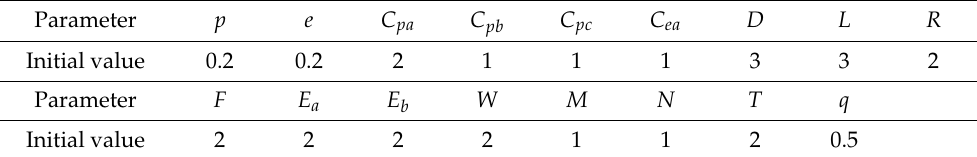
Table 9. Parameter